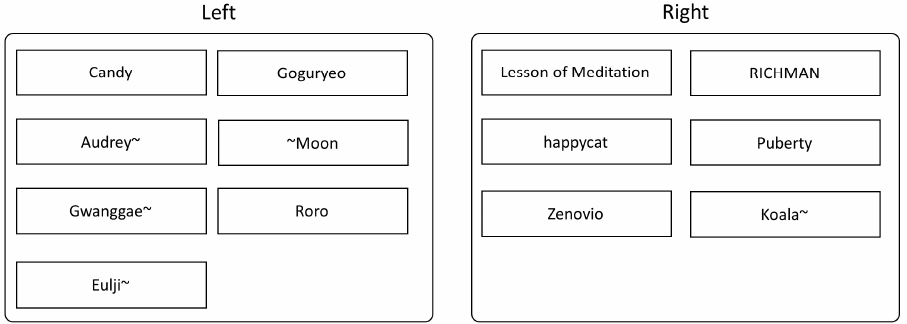
Figure 12. Top users’ political stances.